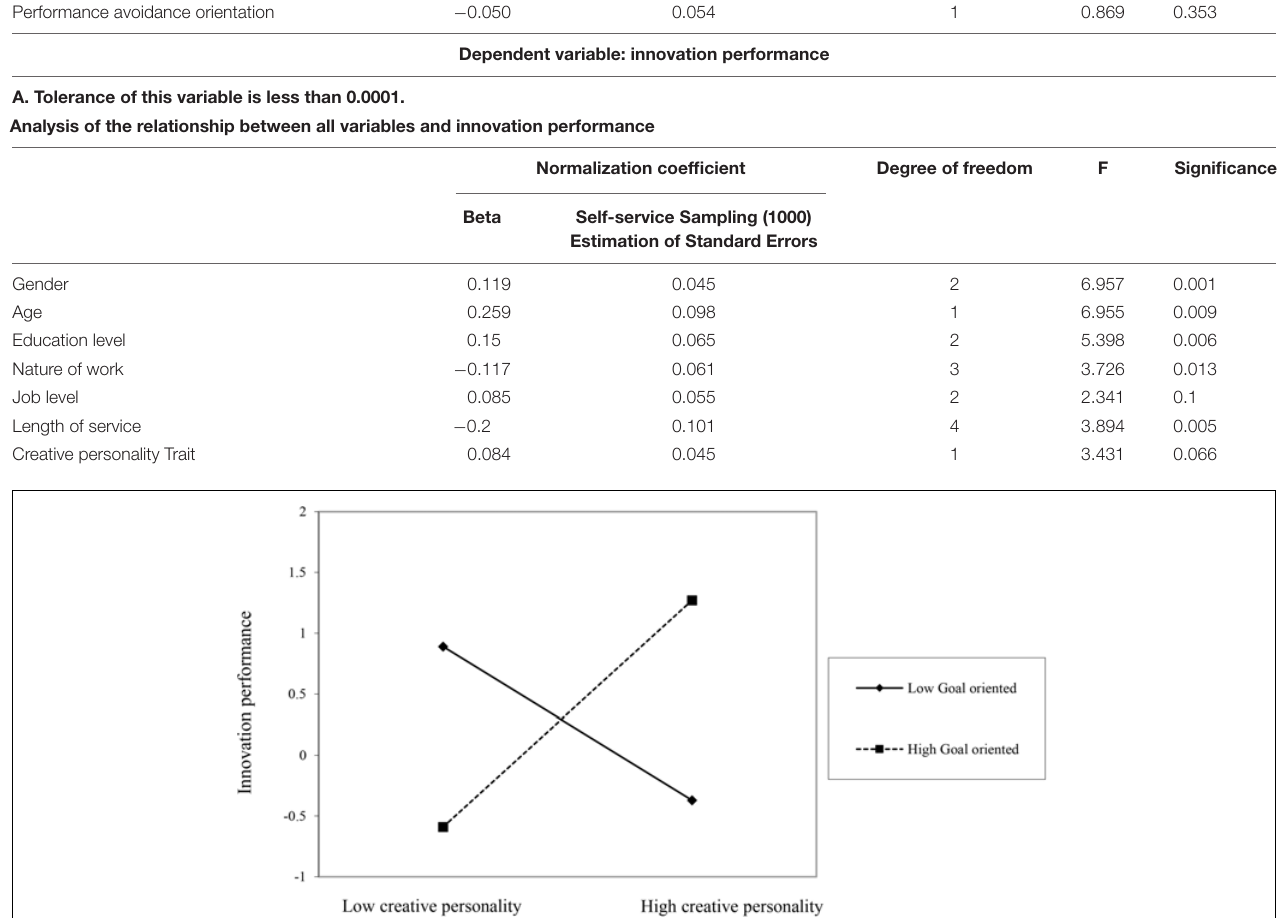
Frontiers in Psychology |